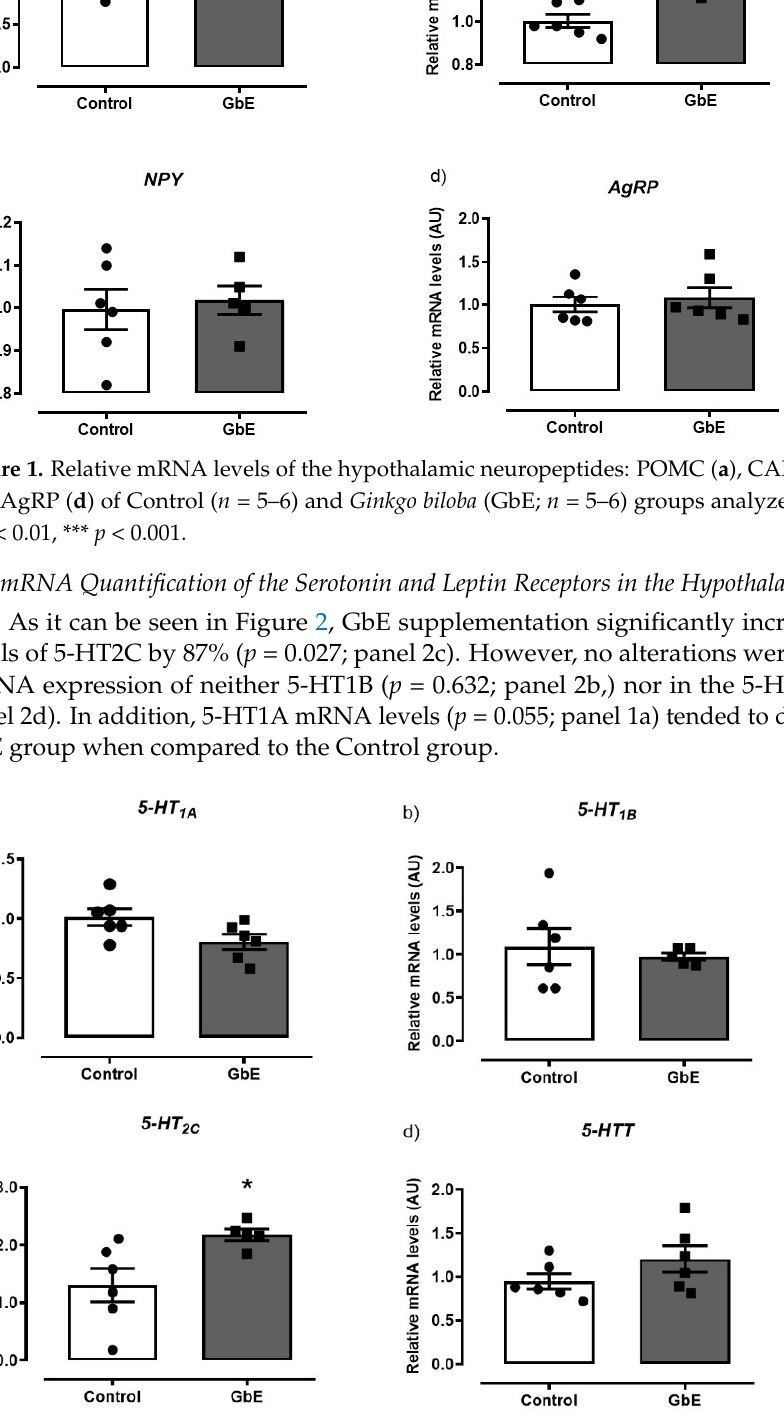
Figure 2. Relative mRNA levels of the serotonin receptors and serotonin transporter: 5-HT1A ( a ), 5-HT1B ( b ), 5-HT2C ( c ), and 5HTT ( d ) of Control ( n = 5–6) and Ginkgo biloba (GbE; n = 5–6) groups analyzed by RT-qPCR. * p <